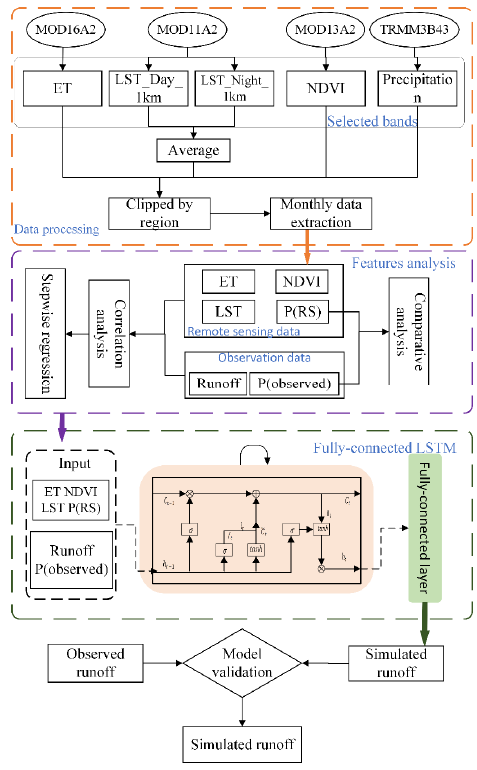
Figure 4. Flowchart of the study. The dashed orange box indicates data processing. The dashed purple box represents the relationship analysis of the data in this study. The dashed black box indicates the runoff simulation process used in the FC − LSTM model.